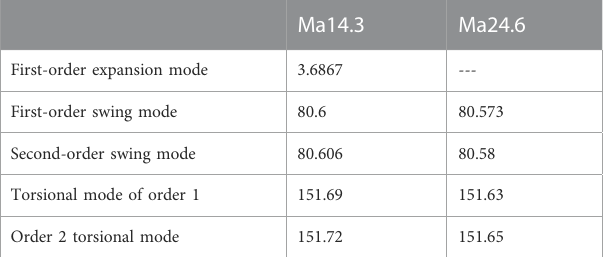
TABLE 6 Vibration modes of various orders of fl exible in fl atable structure (unit: Hz).